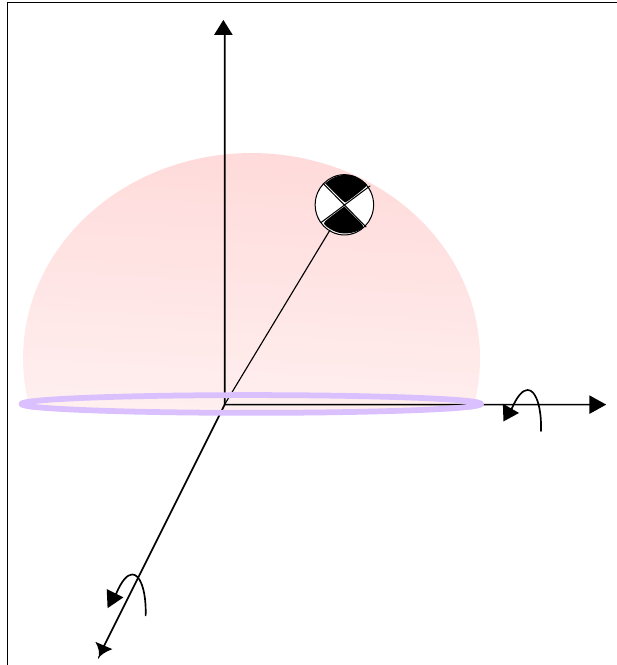
FIGURE 2 | Spherical inverted pendulum with two degrees of freedom at the pivot point